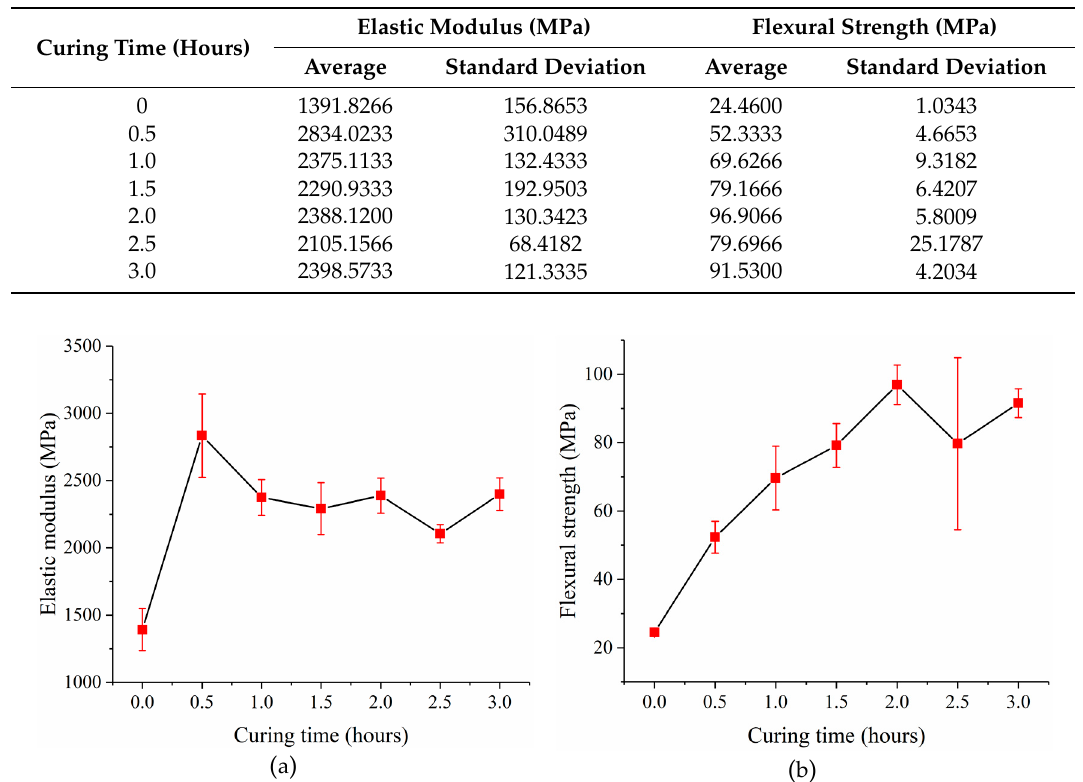
Table 1. The average values and standard deviations of the experimental data.